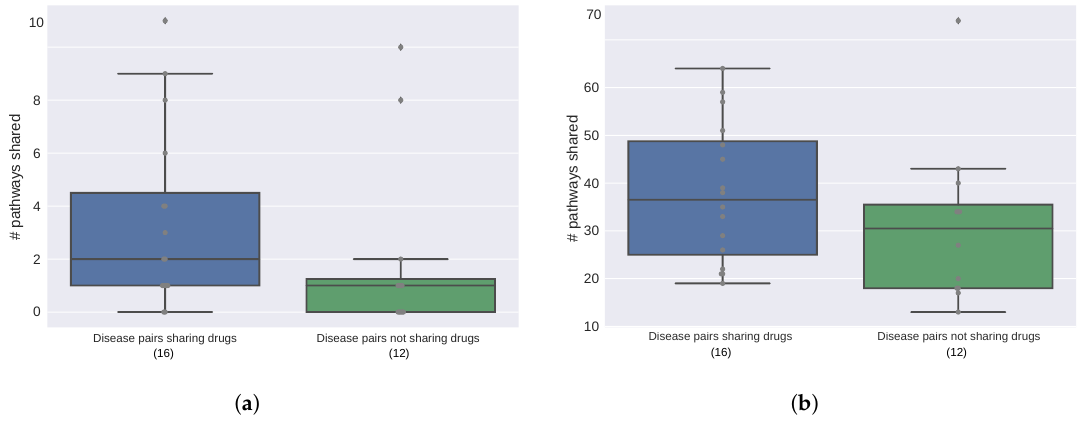
Figure 2. Number of shared pathways across disease pairs that are targeted by the same drug compared to the rest of the pairs. The pathway enrichment is calculated using ( a ) gene overlap and ( b ) proximity of genes in the interactome. The number of disease pairs in each group is given in the parenthesis below the group label in the x